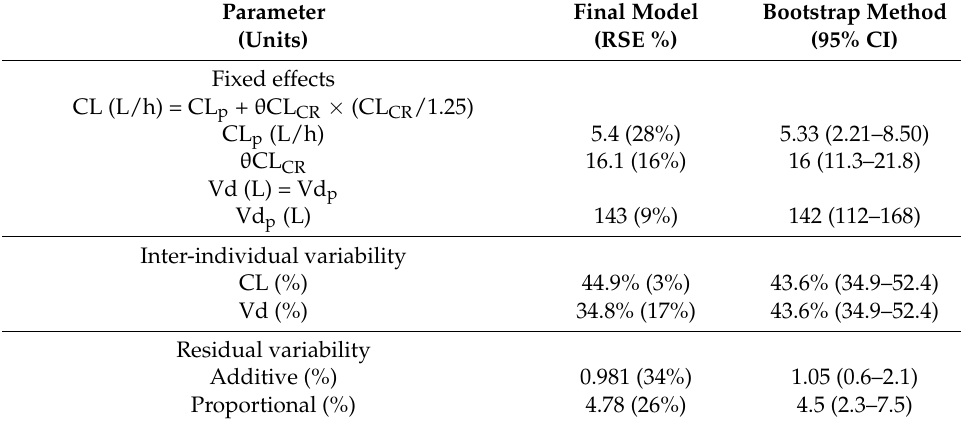
Table 3. Parameter estimates of the final model for ciprofloxacin in critically ill patients.